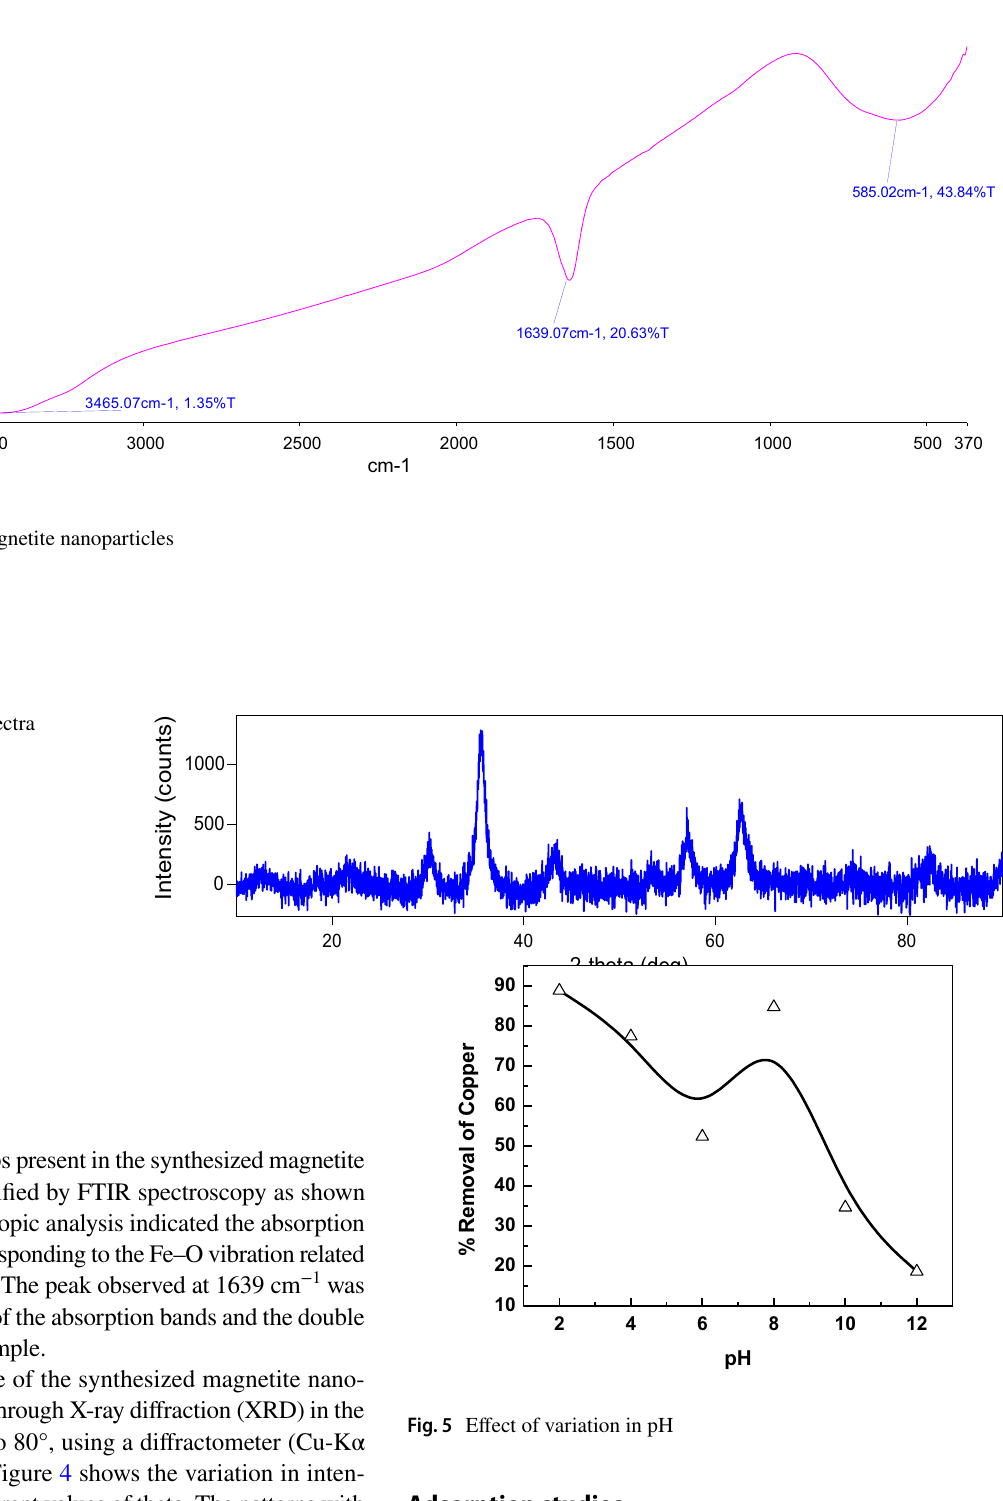
Fig. 5 Effect of variation in